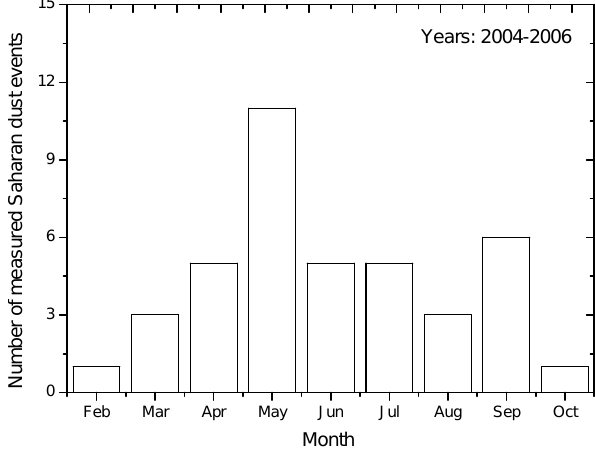
Fig. 1. Number of days per month in which Saharan dust intru- sions are forecasted and observed over Athens during 3 years of lidar measurements (January 2004–December 2006).